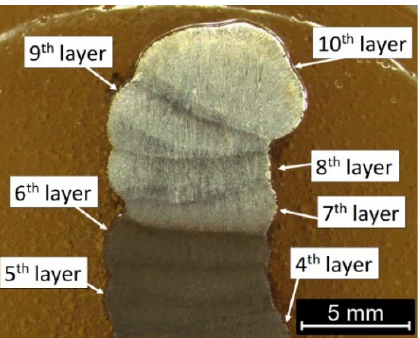
Figure 2. Macrostructure of the wire arc additive manufactured 18Ni-12Co-4Mo-Ti maraging steel